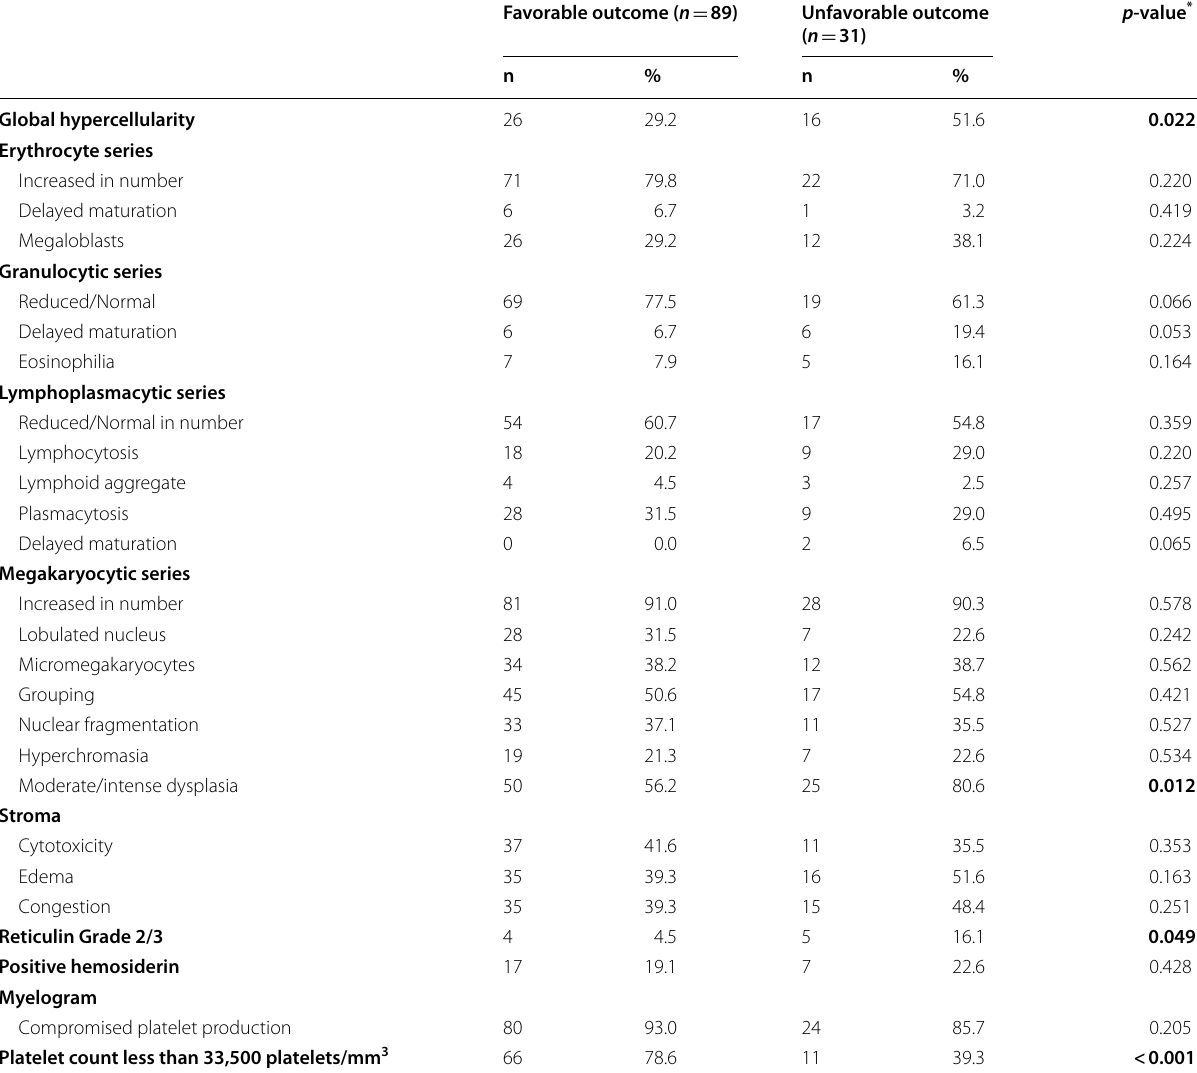
* Statistical tests used: Chi-square and Fisher